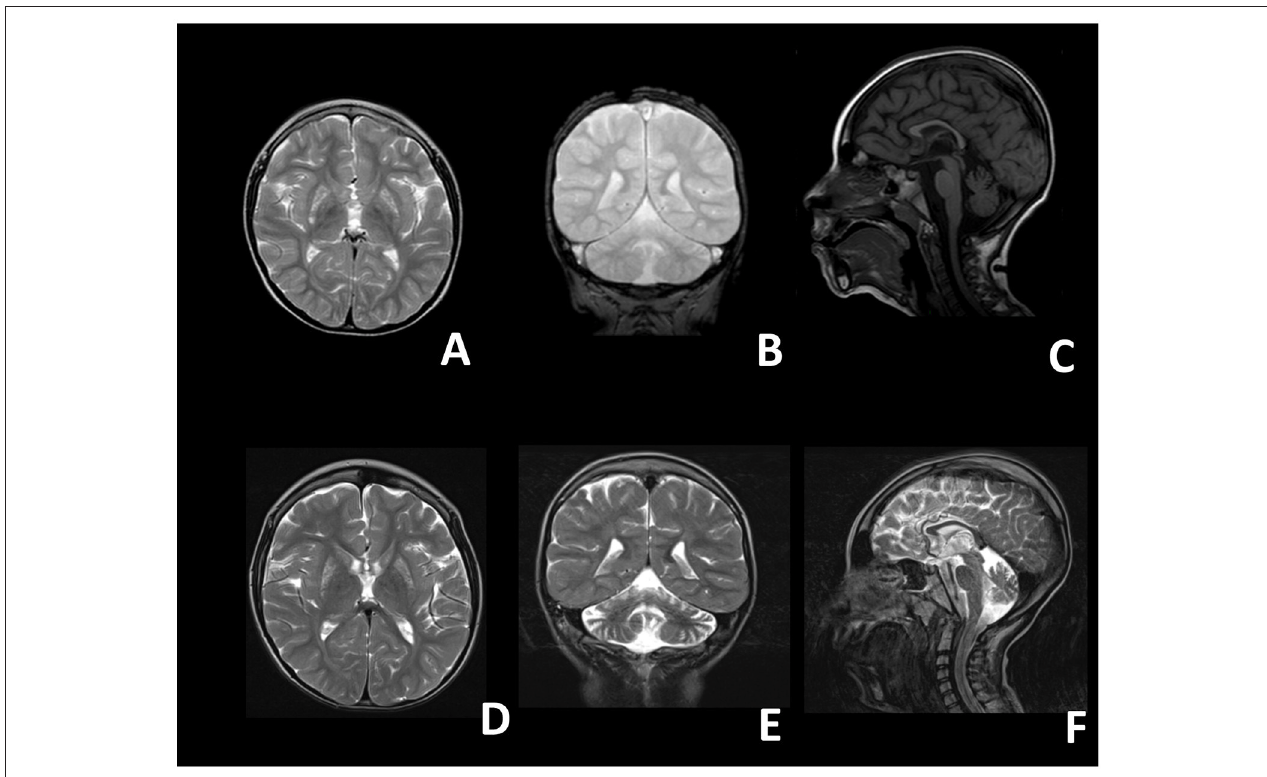
FIGURE 1 | Brain magnetic resonance images of the proband . (A–C) Images taken at 4 years; (D–F) images taken at 8 years. (A) T2 axial, (B) T2 coronal, (C) T1 sagittal, (D) T2 axial, (E) T2 coronal, (F) T2 sagittal. A-D: bilateral inhomogeneous lesions of the Putamen and of the Caudatum. (B–E,F) Progressive cerebellar (vermian and hemispheric) atrophy. (C–F) Thin corpus